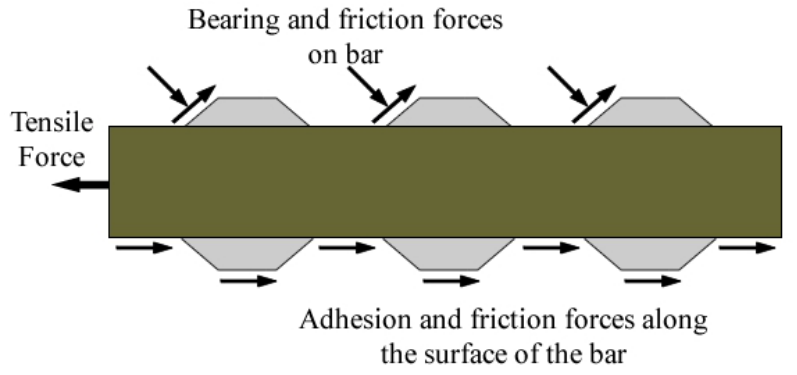
Figure 1. Bond mechanism of FRP bars (modified from